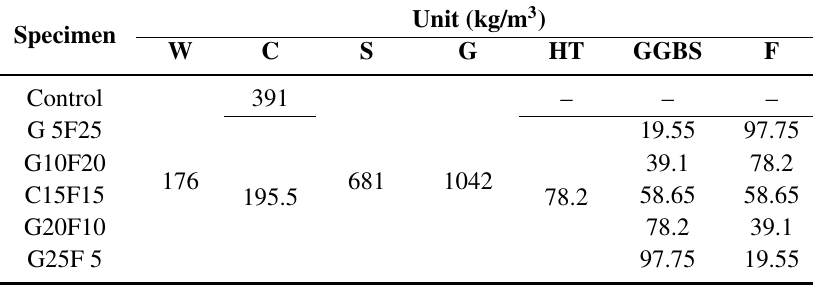
Table 5. Mix proportion of Hwangtoh concrete (W/B 50%, S/a 40%, HT 20%).